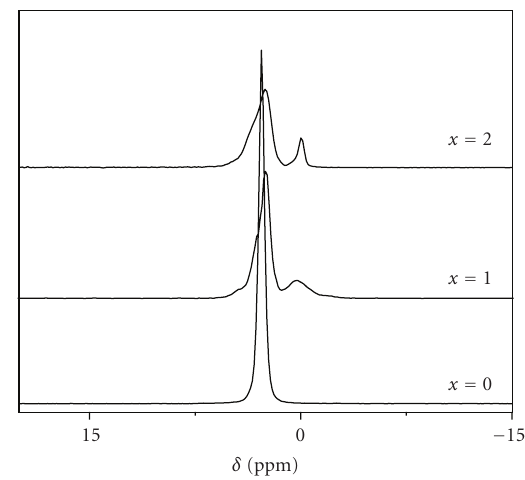
Figure 8: 31 P MAS NMR spectra of M x FA samples sintered at 1000 ◦ C for